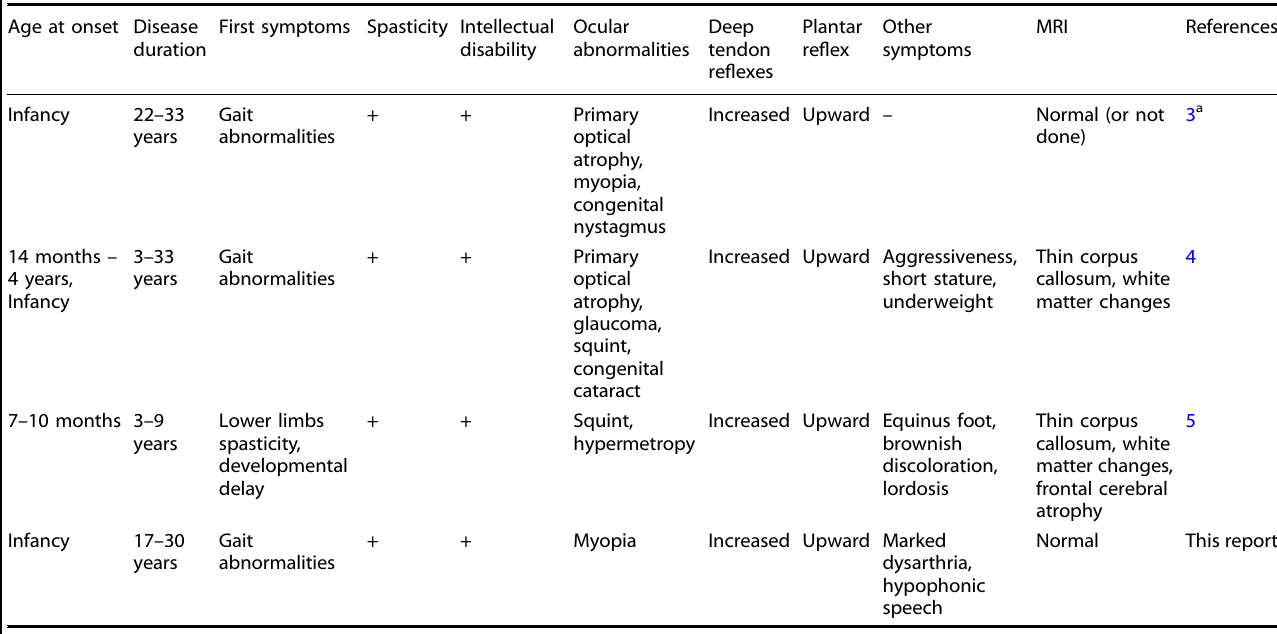
Table 1. Clinical details of reported patients with NT5C2 -associated disease Age at onset Disease First symptoms Spasticity Intellectual duration